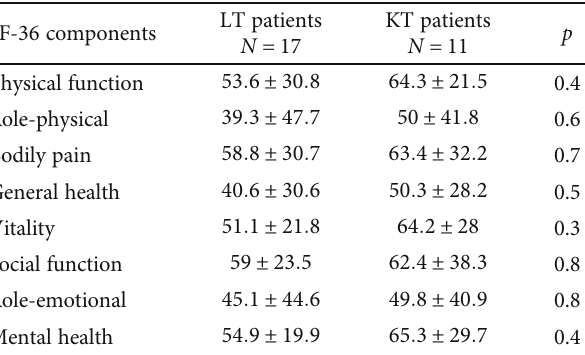
Figure 1: STAI 1, STAI 2, and Zung mean scores at baseline, 12 (T12), and 24 (T24) weeks after the end of DAA therapy in LT and KT patients. Legend: LT: liver transplant; KT: kidney transplant. Table 2: The eight-item SF-36 scores in LT and KT patients at enrollment. Data are expressed as mean ± standard deviation (SD).